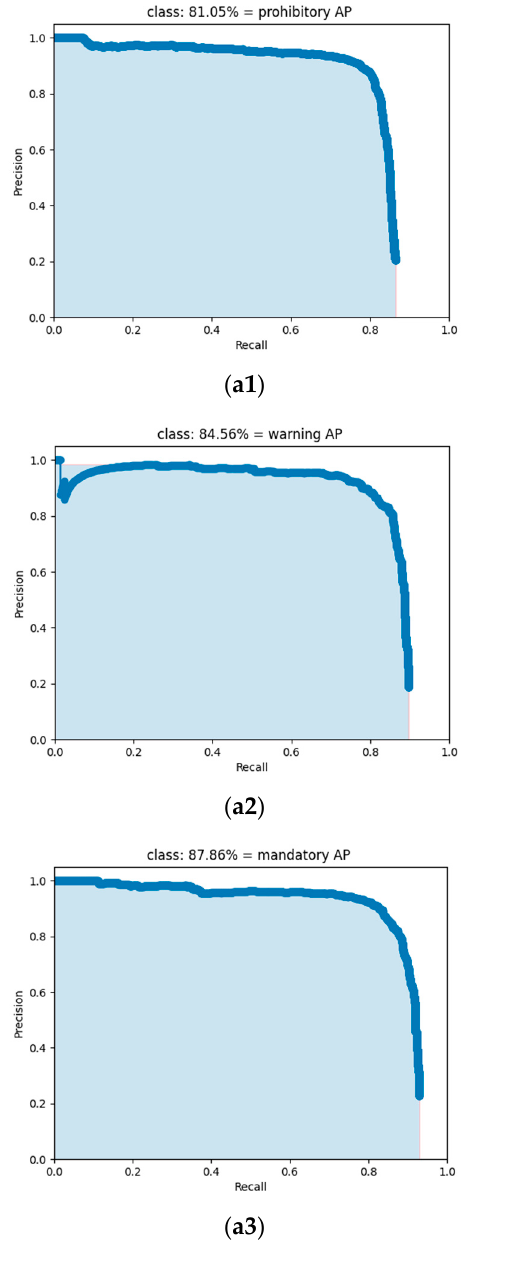
Figure 11. Comparison of PR curves for different categories, where ( a1 – a3 ) are the PR curves for each type obtained by the YOLOv4-tiny algorithm, and ( b1 – b3 ) are the PR curves for each type accepted by the TSR-YOLO model.